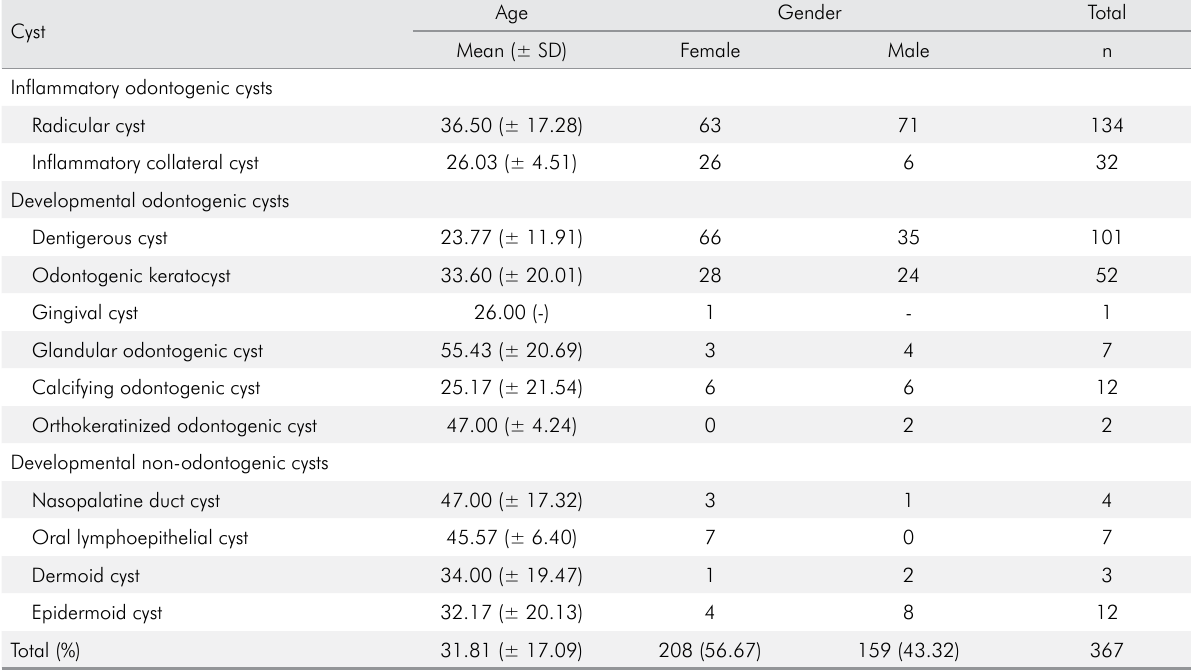
Age Gender Total Mean (± SD)